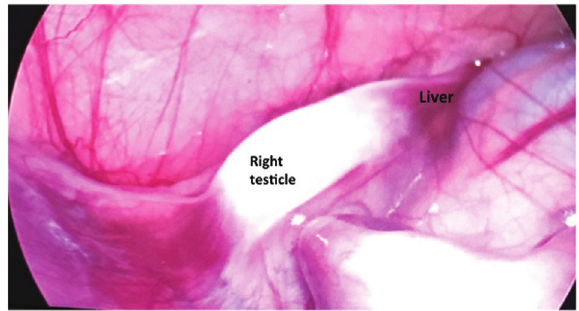
Fig. 2 Laparoscopic evaluation revealed hepatogonadal fusion. A short fi brous cord was attached to the right testis and lower aspect of the right liver lobe.